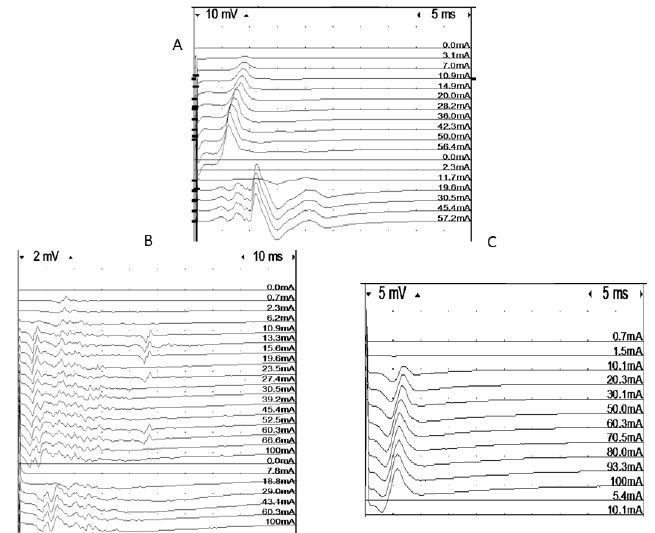
Figure 1. Intramuscular recordings of responses elicited using muscle (dm) and nerve (ne) stimulation in three patients. A = normal, B = low-amplitude responses for both direct and indirect stimulation, C = discrepancy between direct and indirect response amplitude, indicating